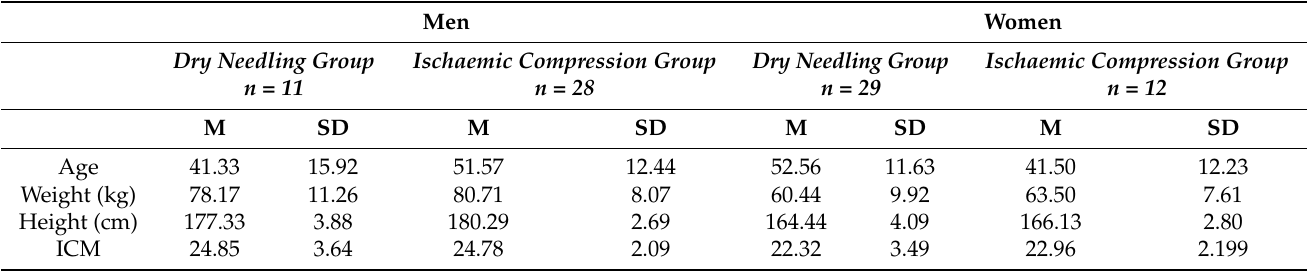
Table 1. Mean (M) and standard deviation (SD) of the control variables, by gender and